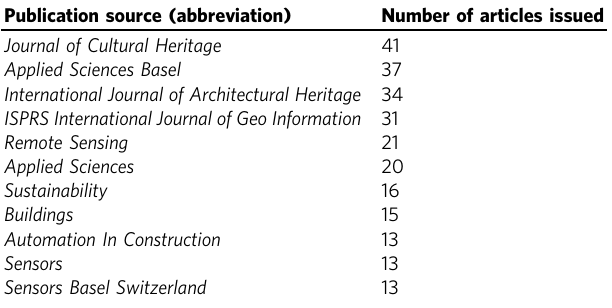
Table 3 Publication sources and number of